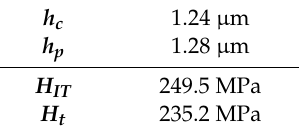
Table 2. Determined h p and H t on the basis of one indentation curve ( F max = 10 mN, (110) direction) in Table 2. Determined ℎ (cid:3043) and 𝐻 (cid:3047) on the basis of one indentation curve ( 𝐹 (cid:3040)(cid:3028)(cid:3051) = 10 𝑚𝑁 , (110) comparison to h c and H IT determined according to the method of Oliver and Table 2. Determined ℎ (cid:3043) and 𝐻 (cid:3047) on the basis of one indentation curve ( 𝐹 (cid:3040)(cid:3028)(cid:3051) = 10 𝑚𝑁 , (110) direction) in comparison to ℎ (cid:3030) and 𝐻 (cid:3010)(cid:3021) determined according to the method of Oliver and Pharr. direction) in comparison to ℎ (cid:3030) and 𝐻 (cid:3010)(cid:3021) determined according to the method of Oliver and Pharr.